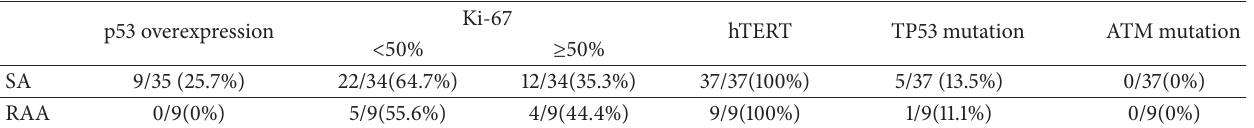
Table 3: Immunohistochemical and mutational analysis of prognostic markers comparing sporadic angiosarcomas (SA) and radiation- associated angiosarcomas (RAA).